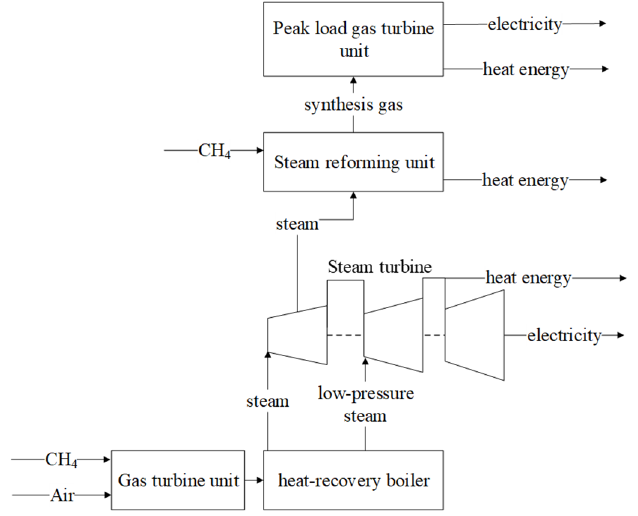
Figure 17. Combined cycle facility equipped with methane steam conversion.